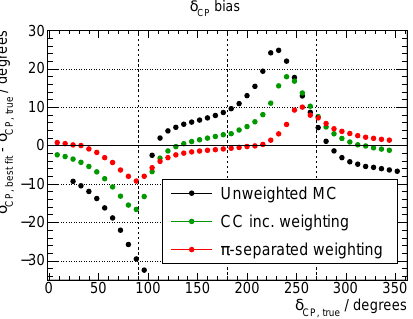
Figure 73. δ CP bias as a function of true δ CP when performing a far detector-only fit with NuWro reweighted mock data. The black points show the resulting bias when using the nominal MC. The red points show the resulting bias when the MC is weighted using the ND-derived weights in E vis , p vis , separated by pion multiplicity. The green points show the bias when the MC is weighted using the ND-derived weights in E vis , p vis with no separation by pion